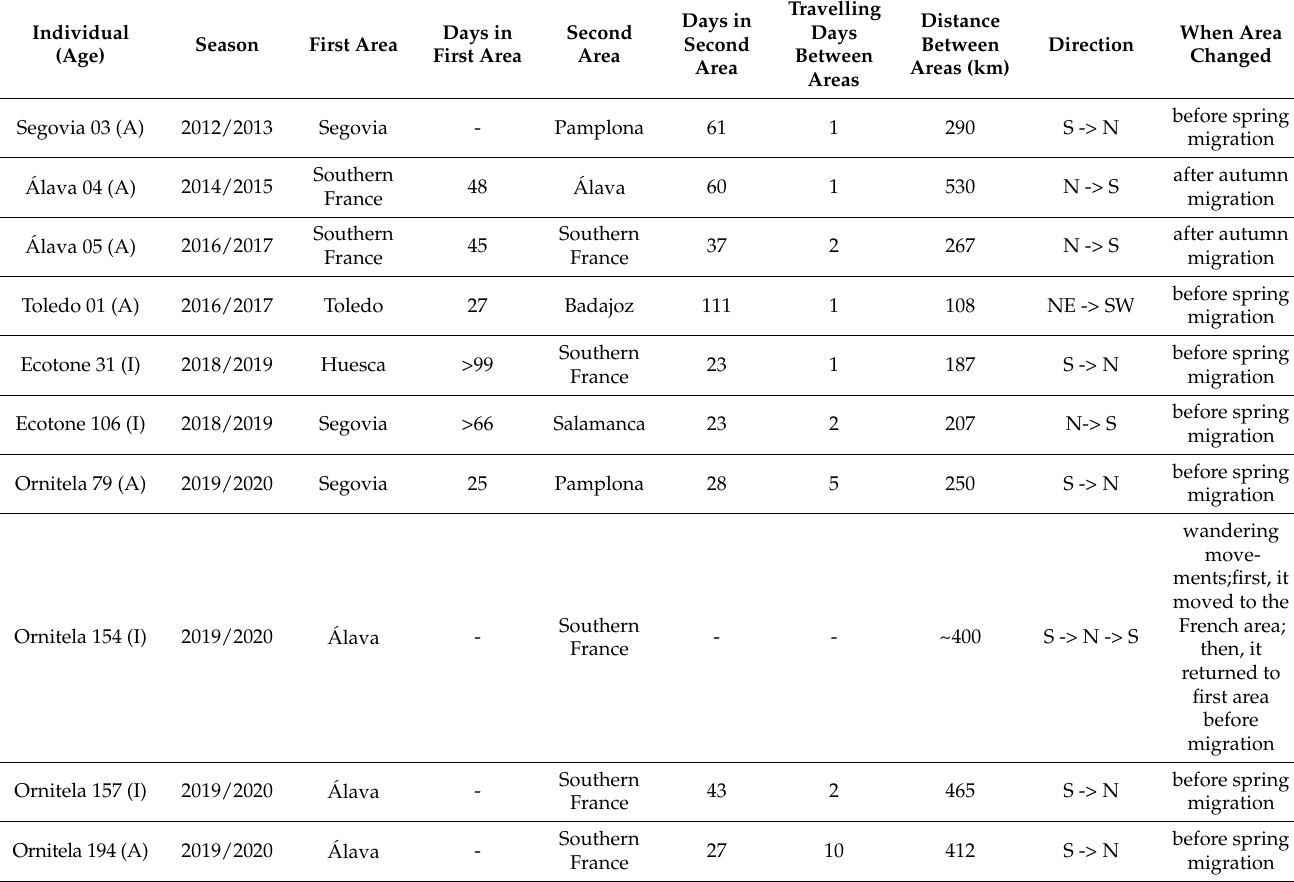
Figure 2. Area shifts performed by individuals during their non-breeding seasons. First (blue) and second (orange) wintering areas are represented for each season. The areas are drawn together in the map but could represent different years. Table 2. Details of movements of the individuals with two wintering areas. All French localities were placed in the south of the